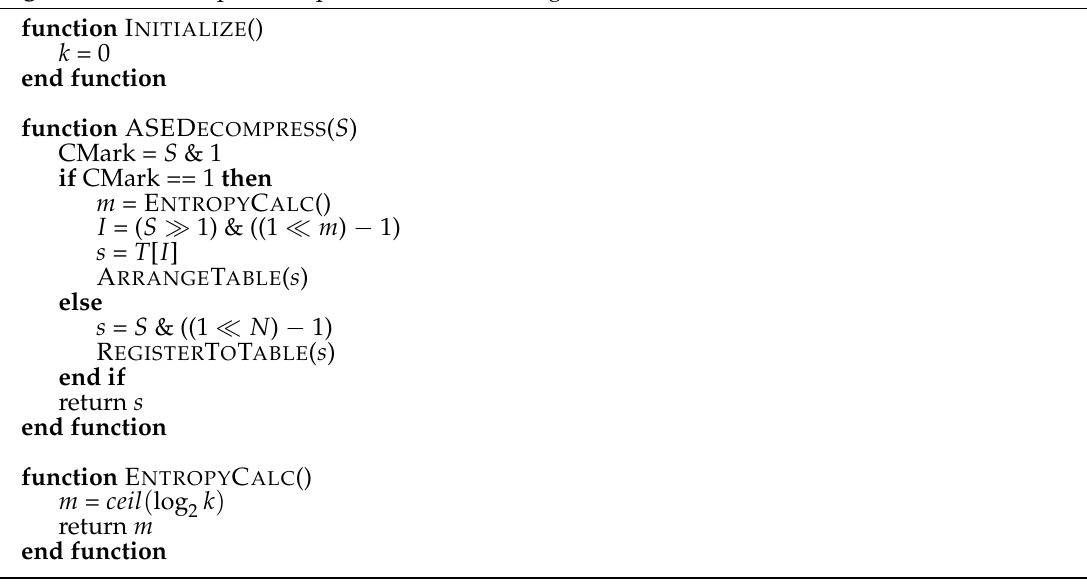
Algorithm 2 Decompression process of ASE coding.